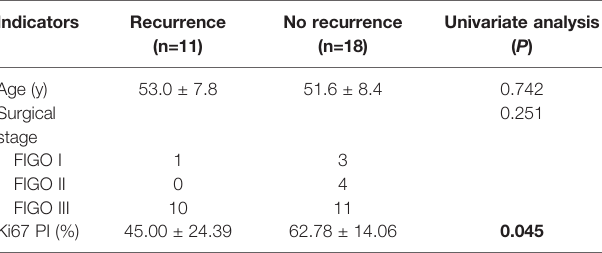
TABLE 1 | The statistical results of univariate analysis of the clinical characteristics of the recurrence and no recurrence groups.